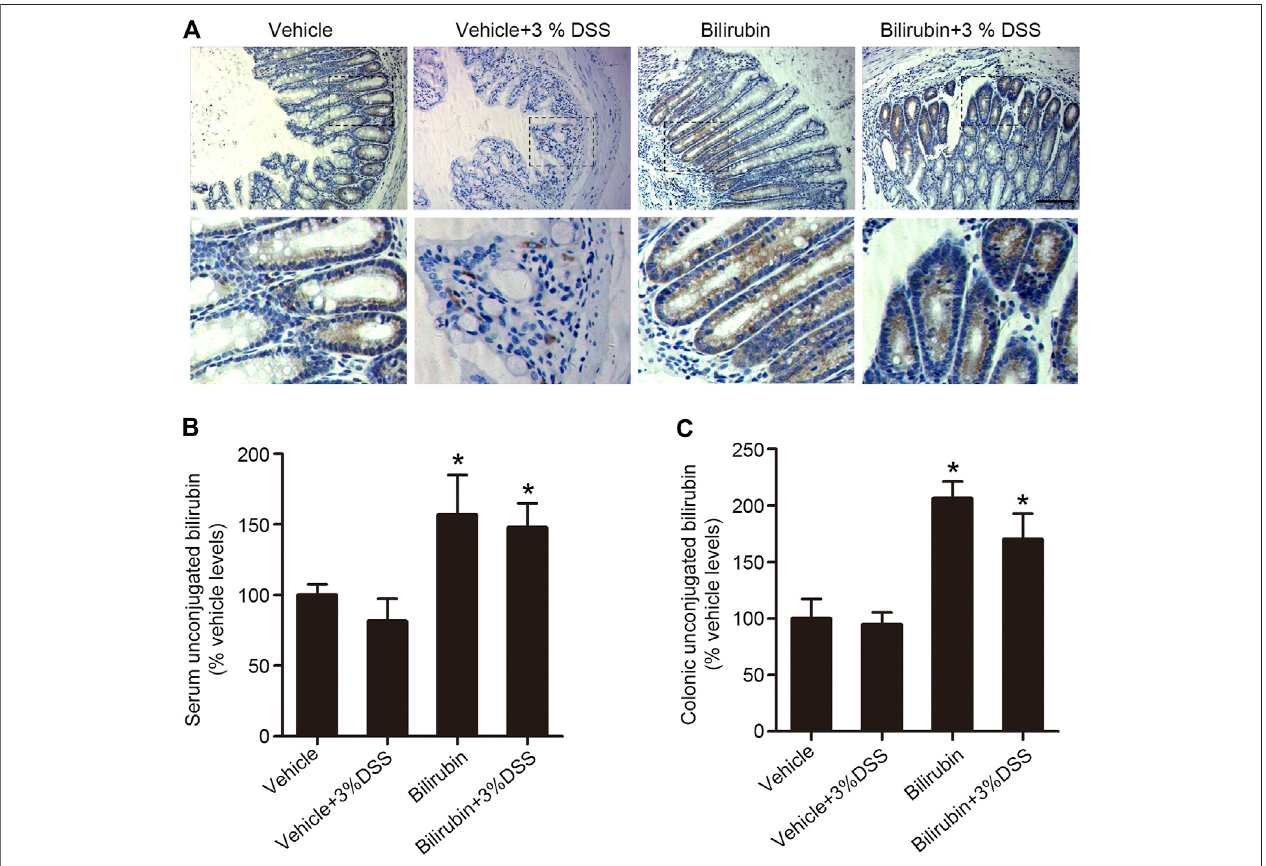
FIGURE 3 | UCB increased plasma and proximal colonic bilirubin levels in the DSS-treated mice. (A) Representative images of proximal colon tissues immune- stained for bilirubin in the indicated groups. Bar (cid:2) 100 μ m. (B, C) UCB levels in the plasma (B) and cecal/proximal colon homogenates (C) as measured by LC-MS/MS. Data are expressed as percentage of controls (vehicle). Each bar represents the mean ± SEM ( n (cid:2) 6); * p < 0.05 vs. the vehicle